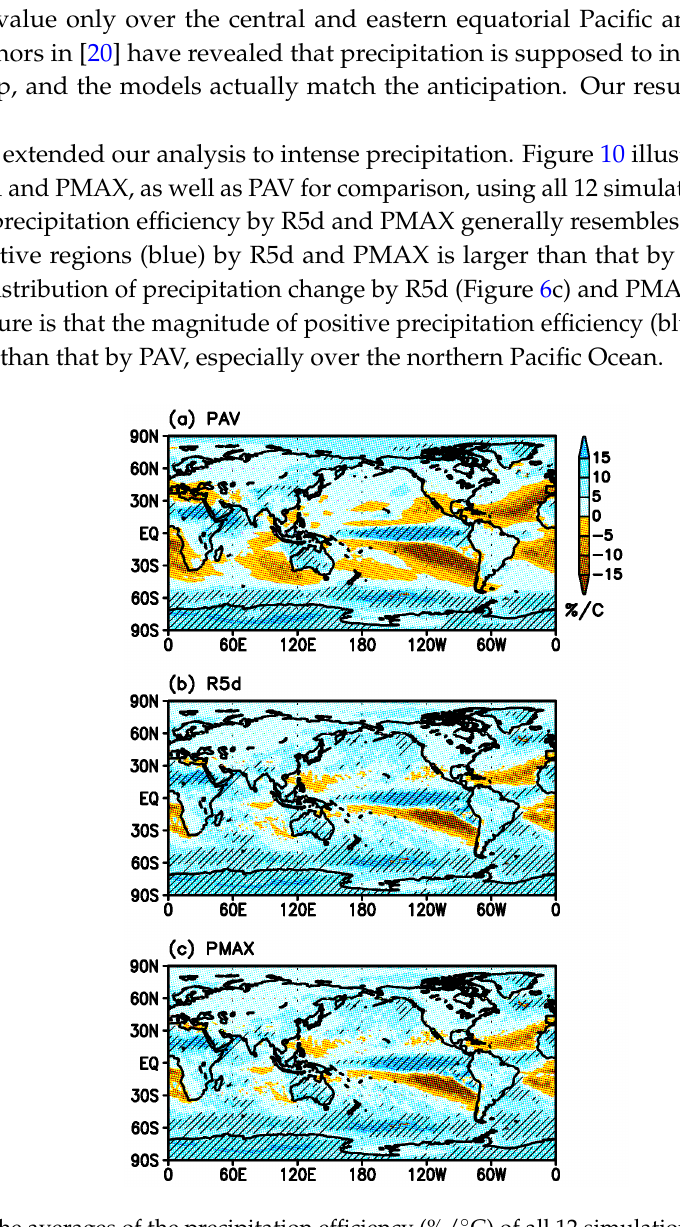
Figure 10. The averages of the precipitation efficiency (%/°C) of all 12 simulations. ( a ) PAV; ( b ) R5d; ( c ) PMAX. Hatched regions indicate that precipitation efficiency is larger than the rate of precipitation increase (7.5%/°C) expected from the C-C relationship.